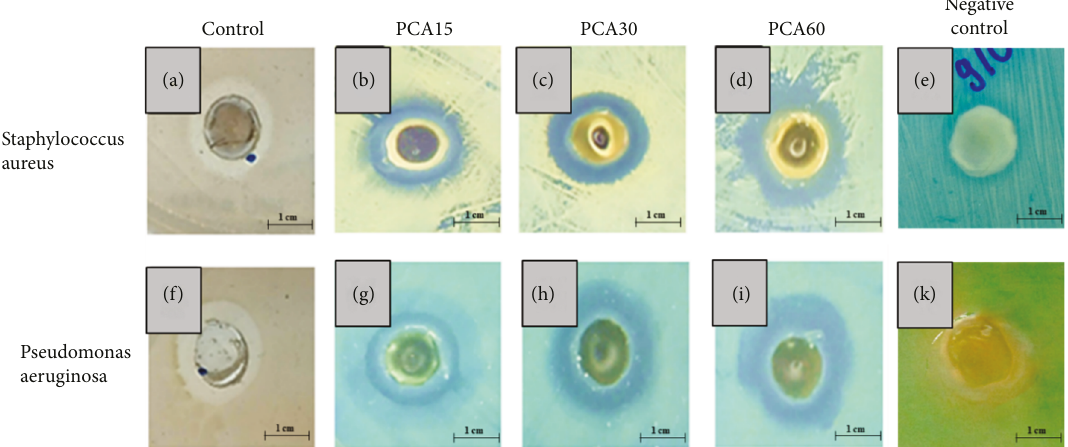
Figure 3: Inhibition area of the positive control group treated with ProGel® (a, f), negative control (e, k), and other groups treated with PCA15 (b, g), PCA30 (c, h), and PCA60 (d, i) in the antibacterial test with Staphylococcus aureus (a – e) and Pseudomonas aeruginosa (f – j).